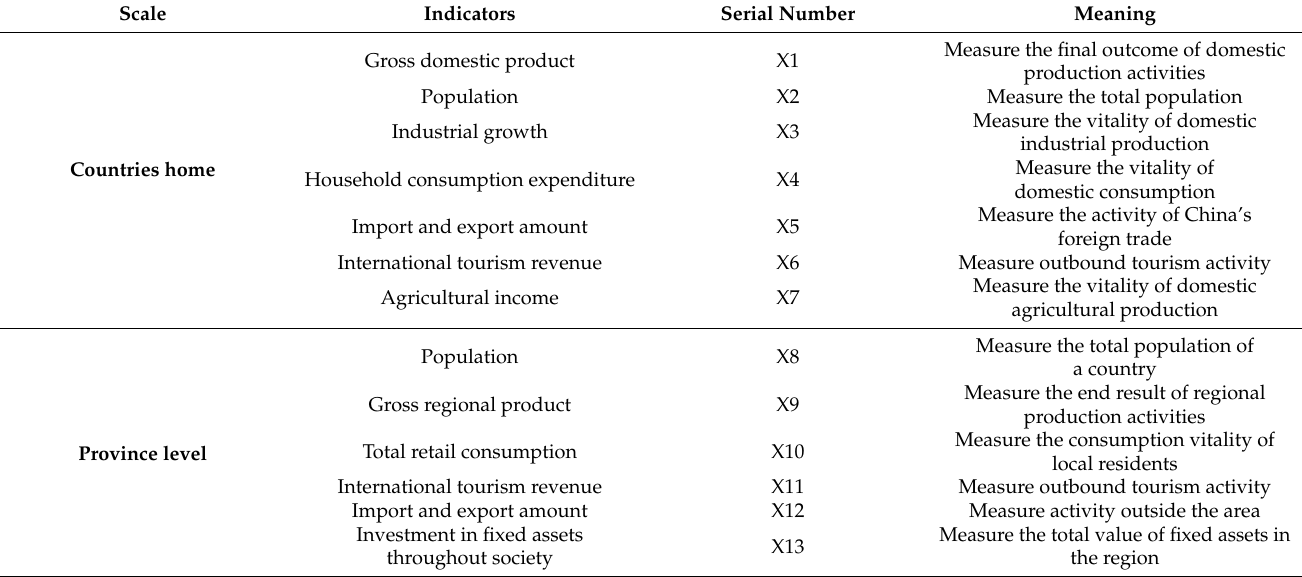
Table 3. Scale index and